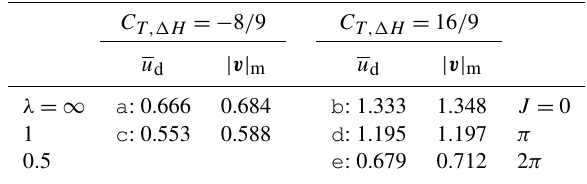
Table 1. Definition of actuator disc flow cases a to e , the average velocity at the disc u d and the absolute velocity in the meridian plane | v | m